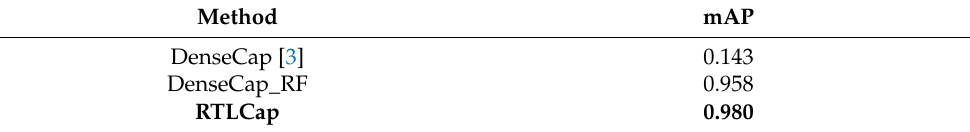
Table 2. The results on the RTL-I dataset.